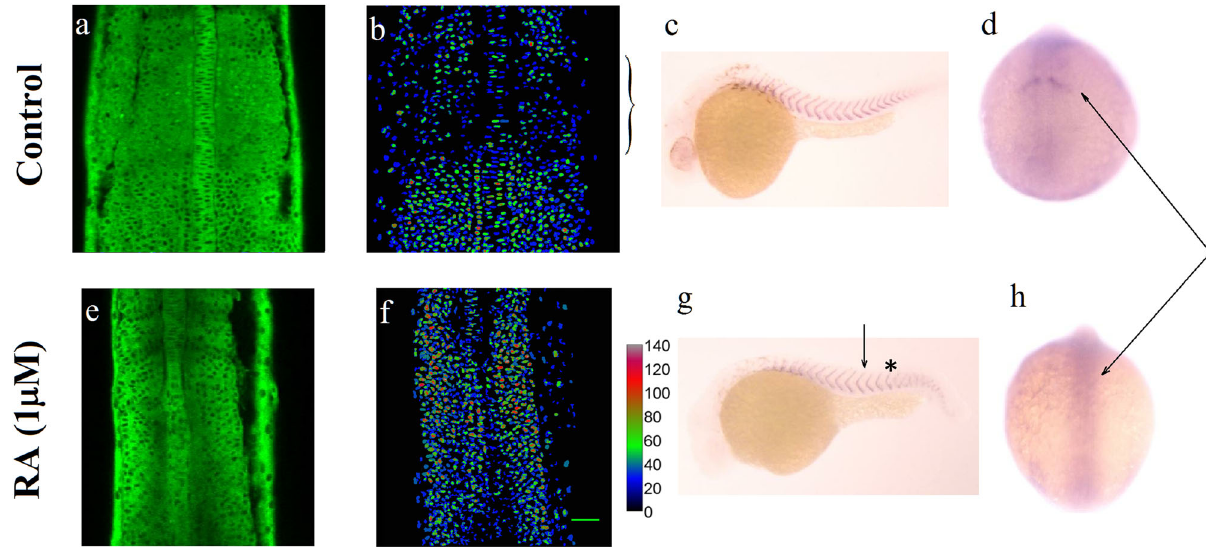
Fig. 3 Somitogenesis at high Erk activity. a – d Control: normal development. a Erk activity in DREKA embryos at 14 somite stage: dark nuclei point to high Erk activity. b The false color images represent the Erk activity averaged over a 30 μ m perpendicular stack of images. c ISH against xirp2a (a marker of somite boundaries) in 30 hpf embryos. d IHC against Mesp2a, a marker of the last somite boundary at 14 somites (arrow). e – h Somitogenetic development in DREKA embryos incubated from one-cell stage in 10 μ M DEAB in presence of 1 μ M RA from the ten somite stage (arrow in g ). e , f The Erk activity is high throughout the PSM. g ISH against xirp2a in 30hpf embryos. Somitogenesis is impaired past 13 somites (indicated by a *) with unclear somite boundaries.